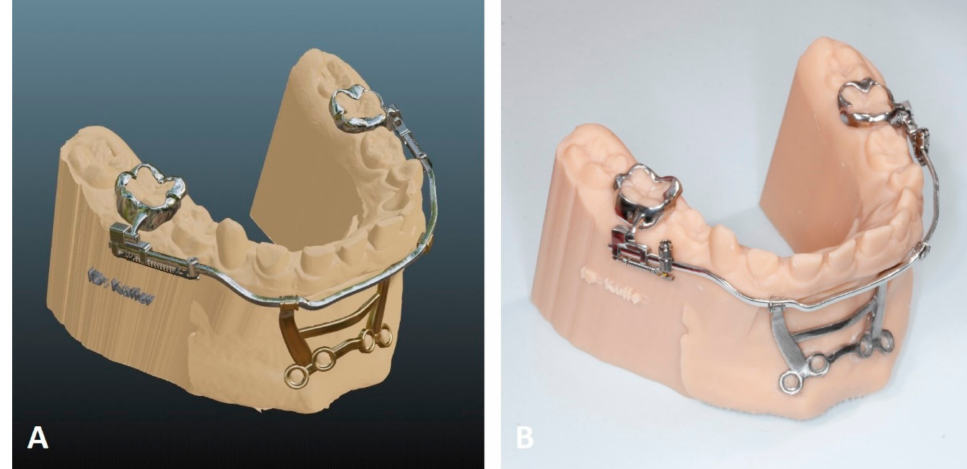
Figure 9. 3D-printed Mentoplate with mesial-slider supra-construction: ( A ) Digital design. ( B ) Finished printed appliance (software: Blender, Blender